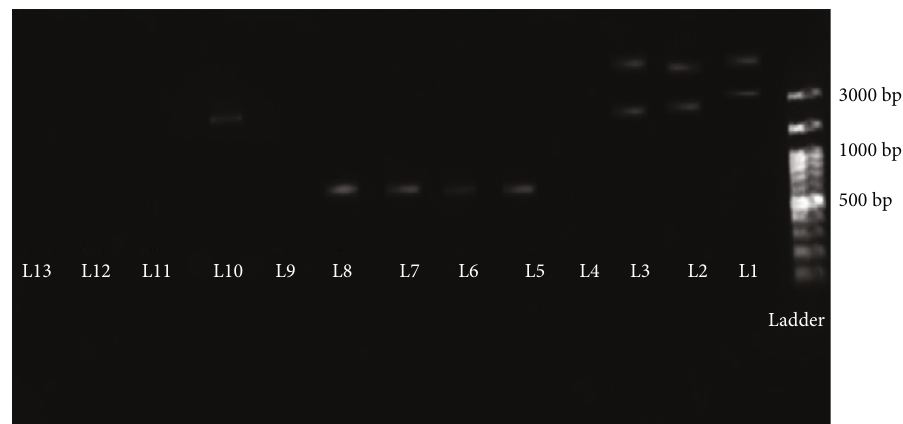
Figure 4: PCR products of 3 colonies with modi fi ed vectors growth on M17 agar. Lane No.: ladder 100bp plus 3 kb (DM2300), lanes 1-3 contributed to the vectors which extracted, lane 4: negative control of PCR with speci fi c primers (pNZ7025-F and pNZ7025-R), lane 5: positive control for PCR with speci fi c vector primers. Lanes 6-8 contributed to PCR products of extracted vector with speci fi c pNZ7025 primers, lane 9 is a positive control for PCR with SDM-F3 and SDM-R2, lane 10 is a negative control for PCR with SDM-F3 and SDM- R2, and lanes 11-13 are PCR products of 3 modi fi ed vector with SDM-F3 and